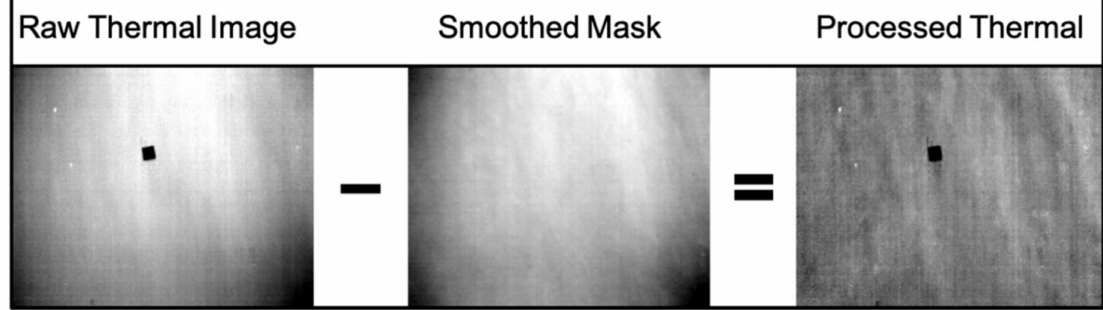
Figure 6. Workflow for processing thermal images to remove edge e ff ect using ArcMap raster